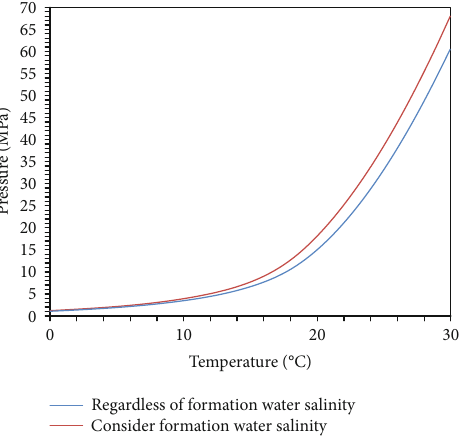
Figure 4: Hydrate phase equilibrium